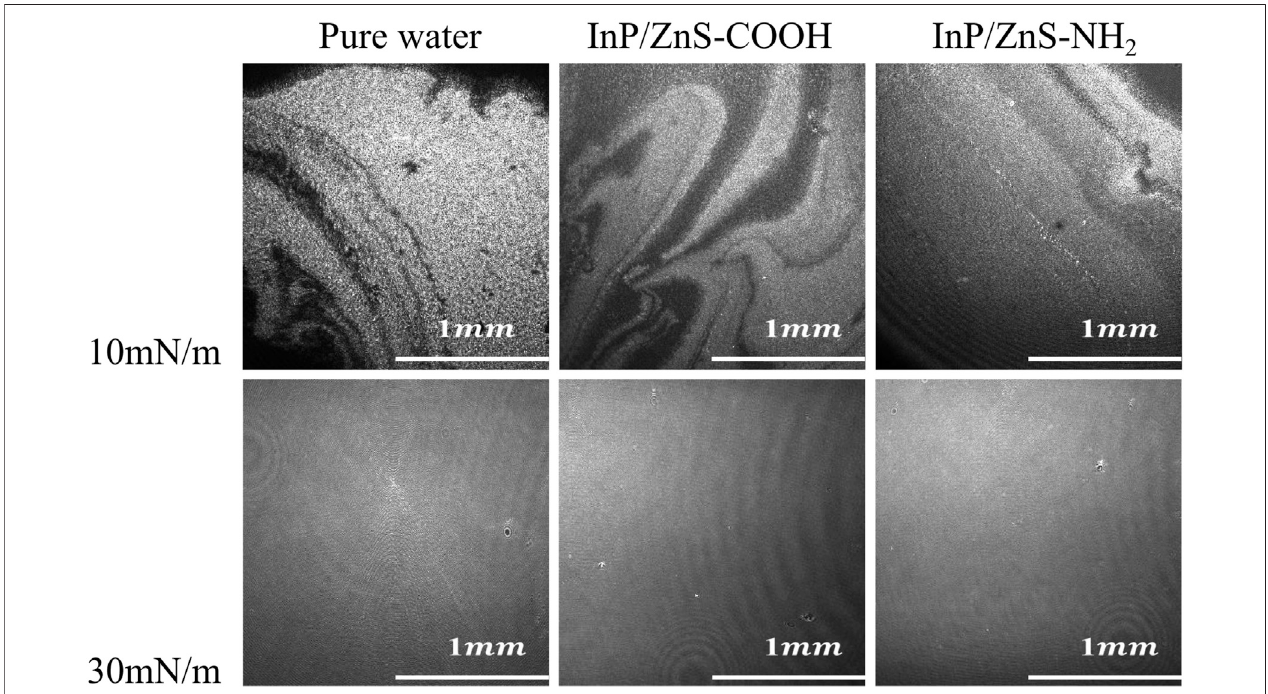
FIGURE6| TheBAMimages(2000 μ m × 2000 μ m)ofthemixedDPPC/DPPG(4:1,molratio)monolayersspreadonthepurewaterandinthepresenceofInP/ZnS QDs modi fi ed by − COOH or − NH 2 group at 10 mN/m and 30